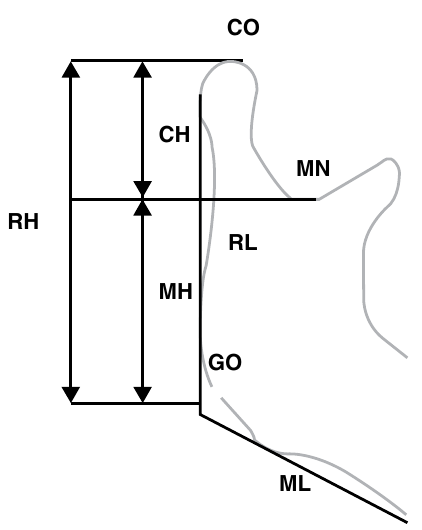
Figure 1. Landmark points of vertical mandibular symmetry according to Kjellberg’s technique.